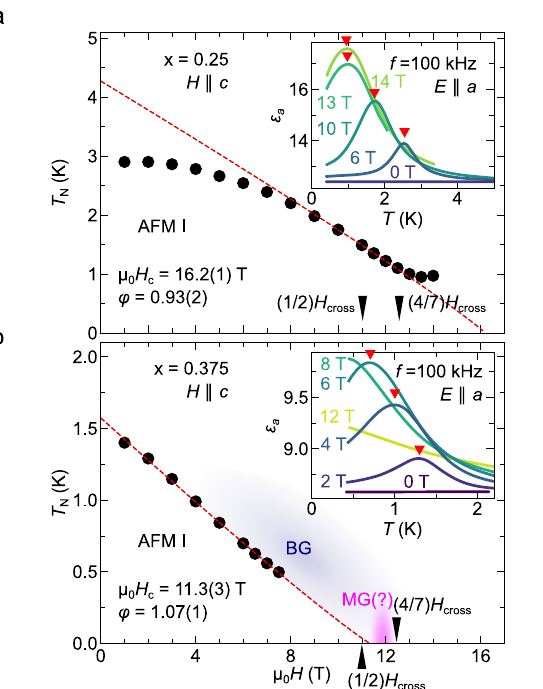
Fig. 5 | Beyond mean- fi eld approach and randomness effect. a , b Low- temperaturephasediagramfor x =0.25and0.375,respectively.Thelattercontains provisionalsuggestionsonBose-glass(BG)andMott-glass(MG).The fi ttingstothe power-law T N ∝ ∣ H − H c ∣ φ , are also shown by red dashed lines. The predicted values of (1/2) H cross and (4/7) H cross from the previous reports 23,28 are shown as black triangles(seetext).Insetshowsthetemperaturedependenceof ε a ,whichisusedto obtain the ordering temperatures (red triangles). c Schematics of effective S =1